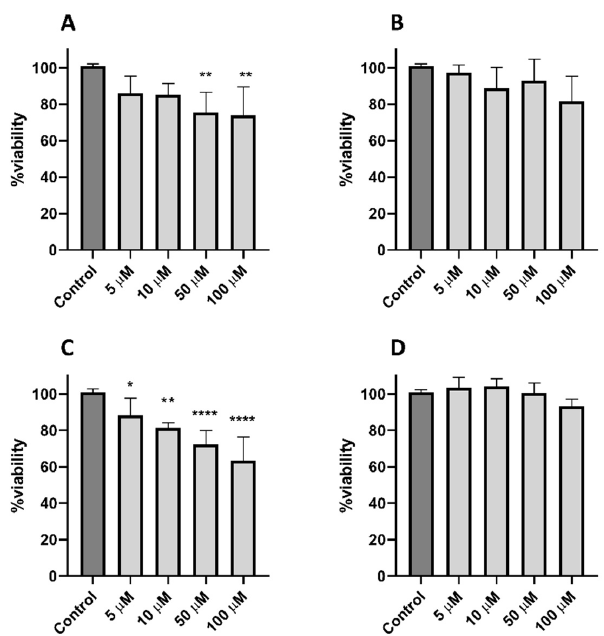
Figure 6. Cytotoxicity tests performed on 3T3 murine fibroblasts with Ma1 and Ma2 peptides. ( A ) Ma1 at 24 h, ( B ) Ma2 at 24 h, ( C ) Ma1 at 48 h, and ( D ) Ma2 at 48 h. All data are represented as the mean ± SD, and one-way ANOVA with Dunnett’s multiple comparisons test was performed in comparison with the Control (* p < 0.05, ** p < 0.01, **** p < 0.0001).